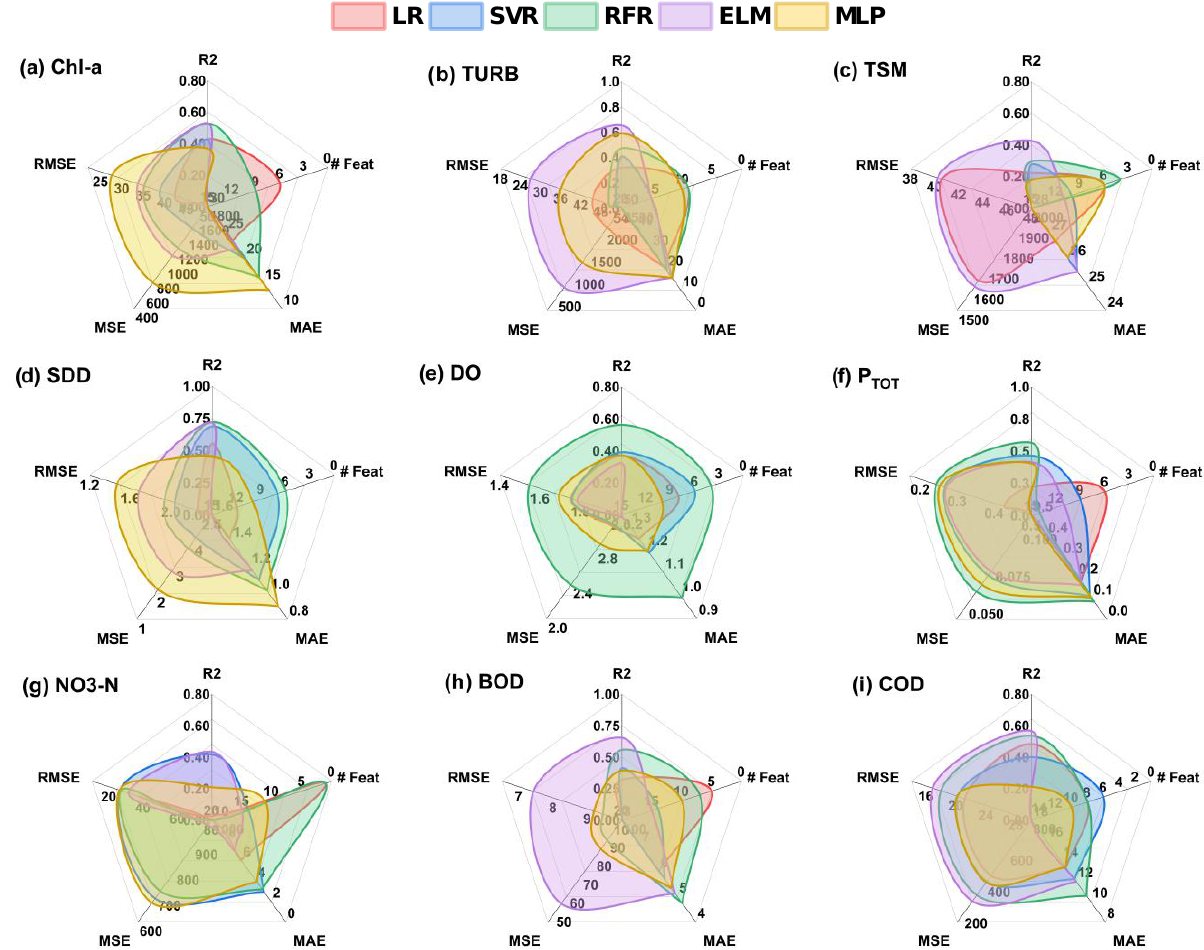
Figure 4. Comprehensive evaluation of tested algorithms based on the relevant error metrics for optimal performance. The algorithms use the best source dataset in all cases.